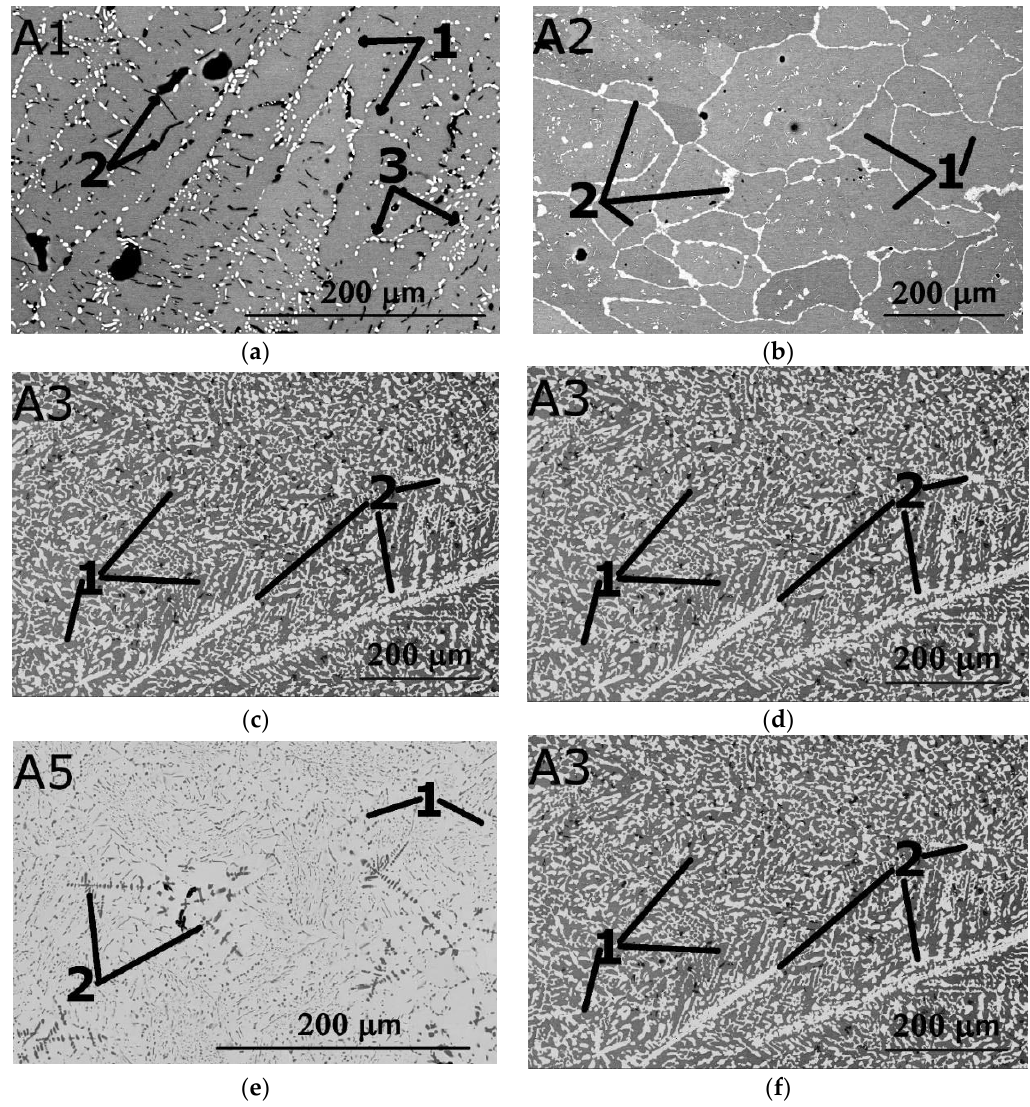
Figure 10. SEM-BSE images of the A1-A6 alloys, A1 ( a ), A2 ( b ), A3 ( c ), A4 ( d ), A5 ( e ) and A6 ( f